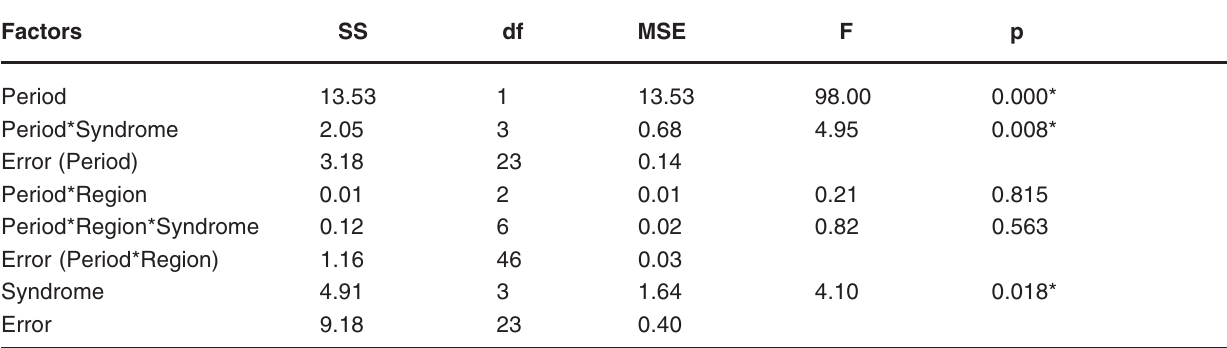
TABLE 7- Comparison of the O’Leary plaque index according to period, region and syndrome